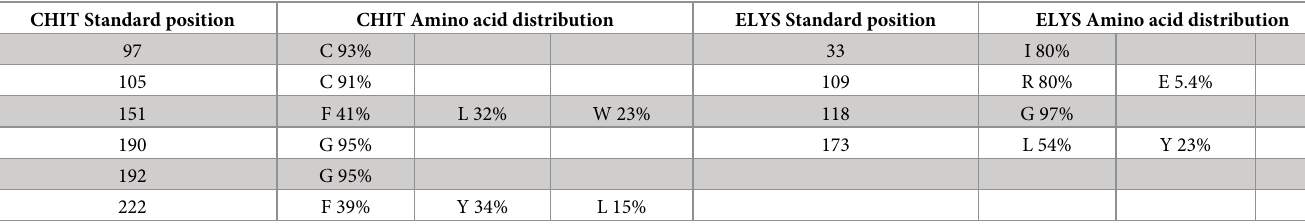
Table 2. Frequency distributions of amino acids at standard positions used to define sequence patterns specific for CHIT and ELYS subfamilies. Information is pro- vided about the percentage of conserved residues at each subfamily specific standard numbering scheme position if higher than 5%. CHIT Standard